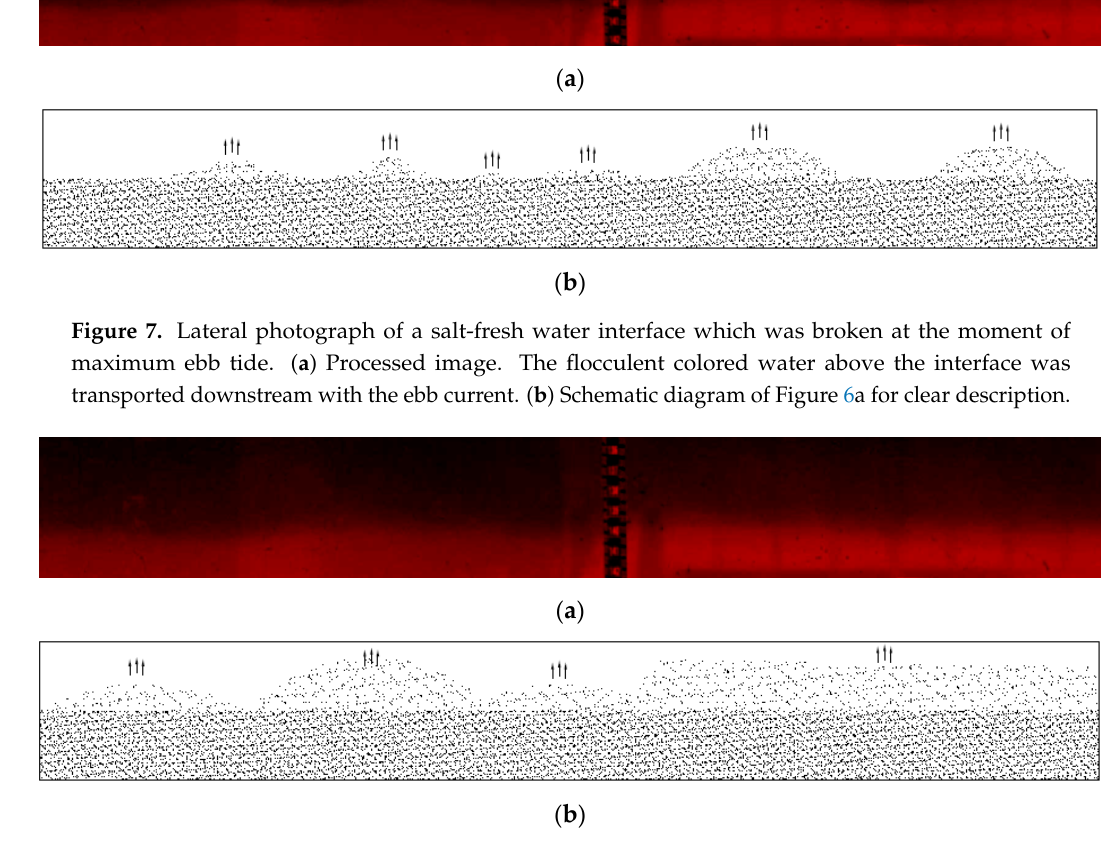
Figure 8. Lateral photograph of a salt-fresh water interface under the entrainment effect. ( a ) Processed image. A large amount of colored water was drawn into the upper colorless water when the velocity gradient increased to a certain degree at the interface. ( b ) Schematic diagram of Figure 7a for clear description.